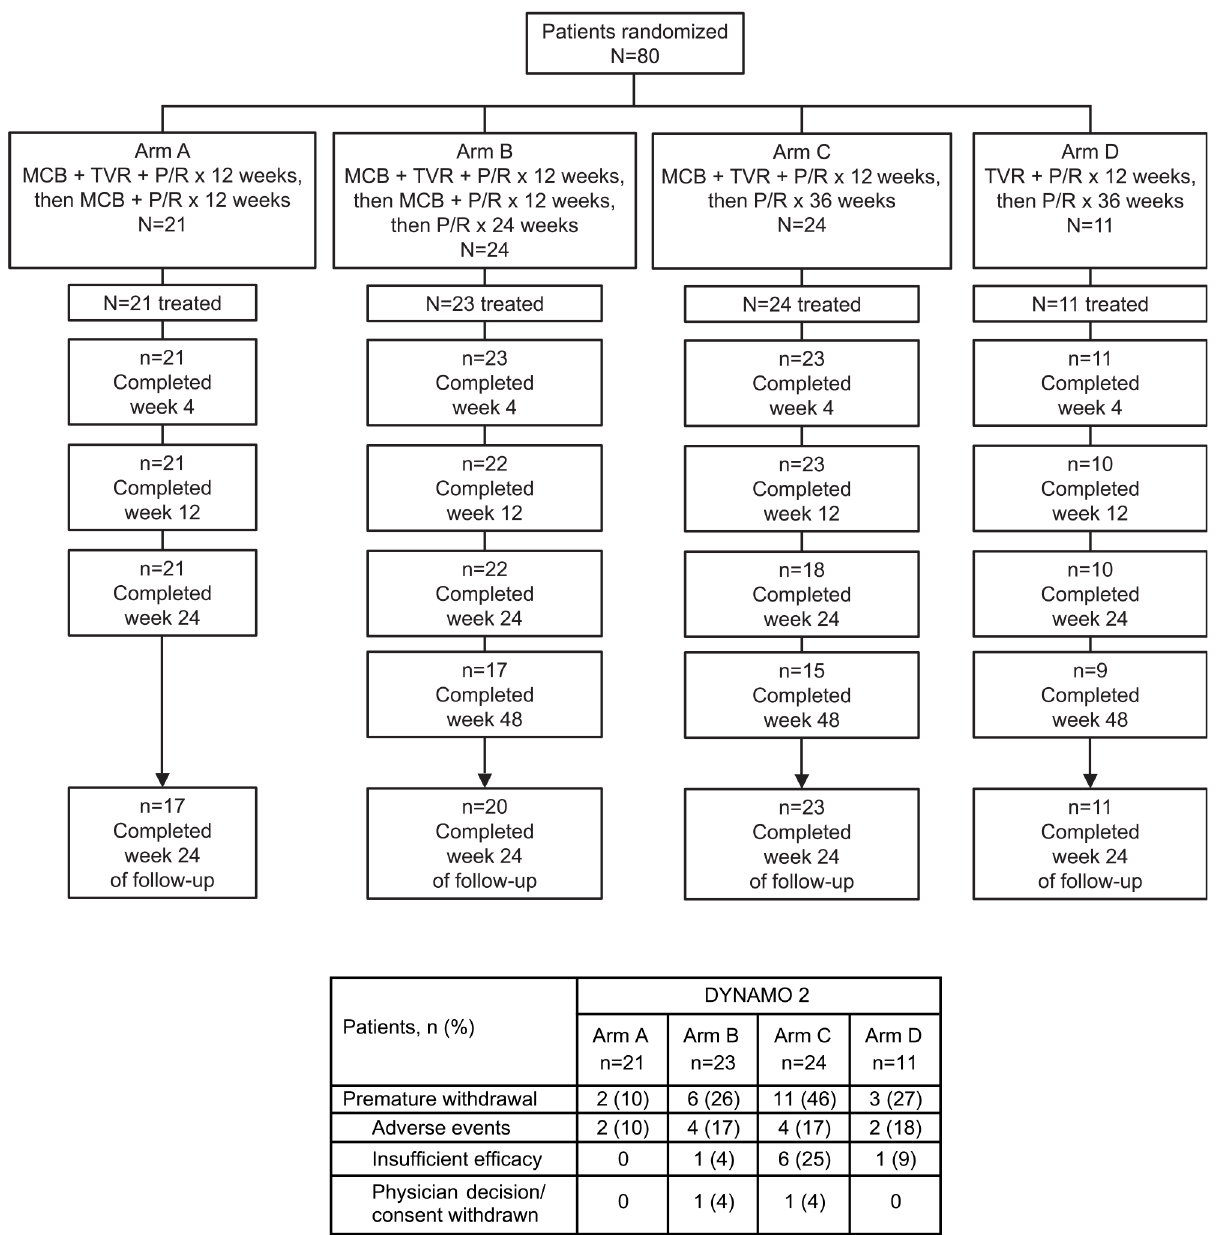
Fig 2. Patient disposition in DYNAMO 2. MCB, mericitabine; P/R, peginterferon alfa-2a + ribavirin; TVR,